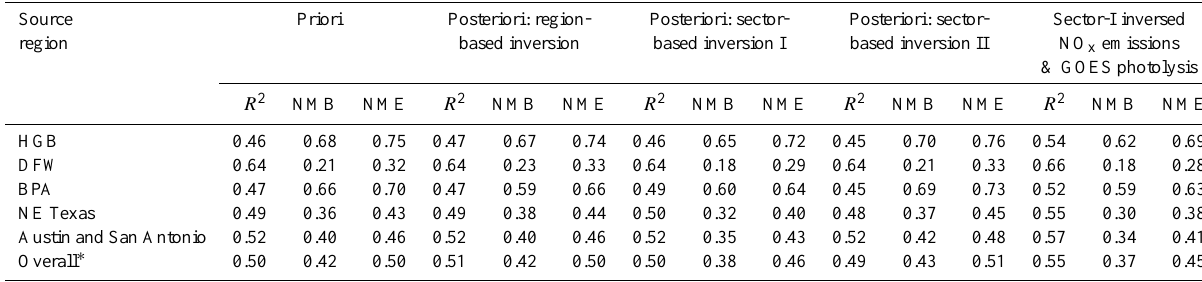
Table 6. Evaluation of CAMx-modeled O 3 using hourly AQS ground-measured O 3 .